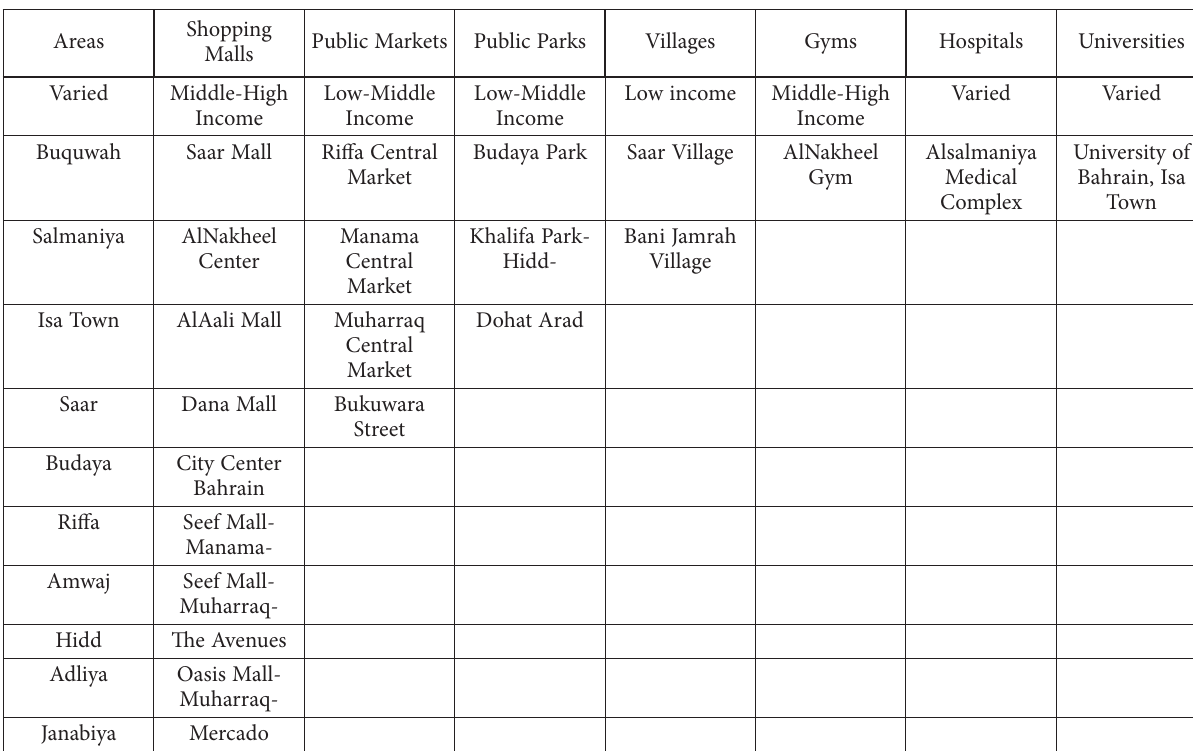
Table 1. List of public places and the socio-economic status of the sample